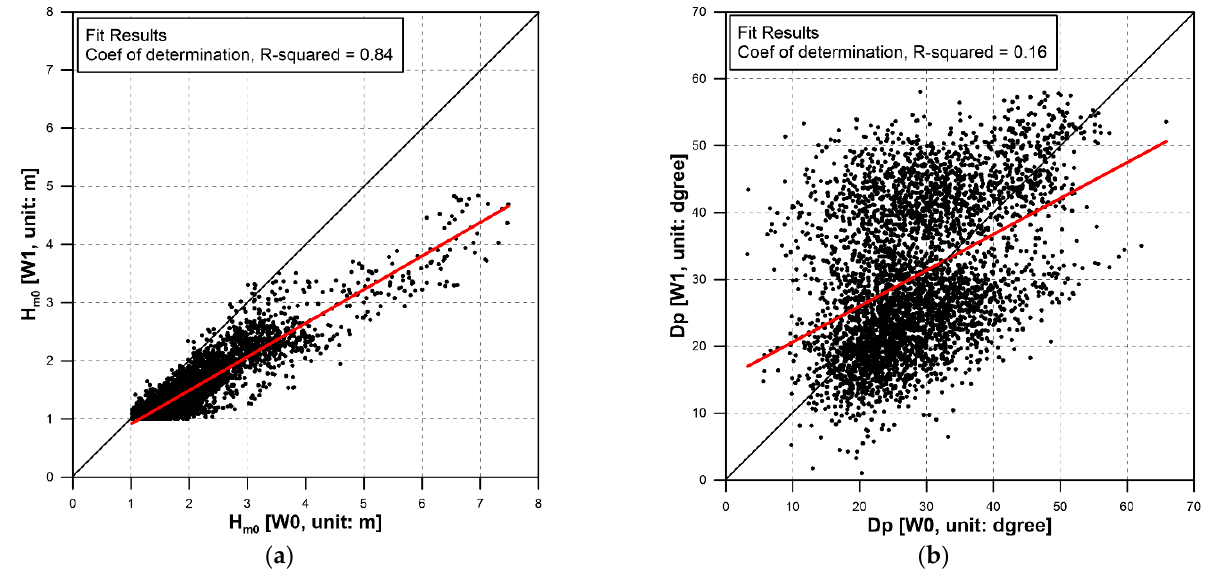
Figure 7. Comparison of the distributions of ( a ) significant wave height ( H m 0 ) and ( b ) peak wave direction ( D p ) between W0 and W1 for the selected events for both BC (only for the second period from 2018 to 2019) and AC. The coefficient of determination ( r 2 ) was 0.83 for H m 0 and 0.16 for D p . Wave measurements show a high correlation in H m 0 between the two wave stations of W0 and W1, whereas they show a lower correlation in the case of D p